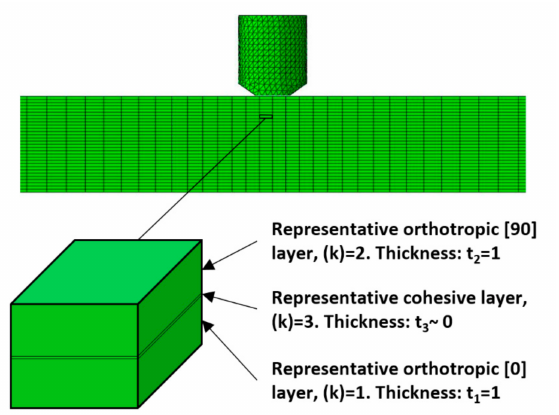
Figure 2. Representative volume element (RVE) of the sublaminate